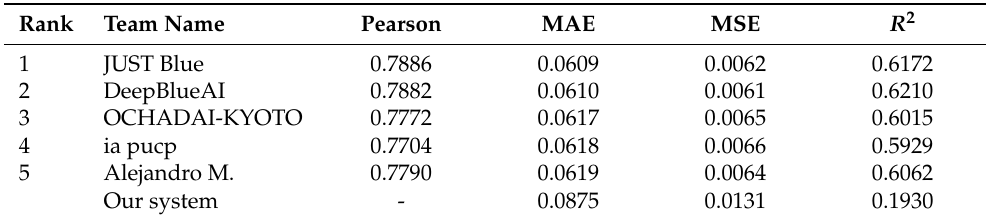
Table 5. Subtask 1: results and rank in terms of Pearson, MAE, MSE, and R 2 in SemEval 2021. The rank evaluation corresponds to